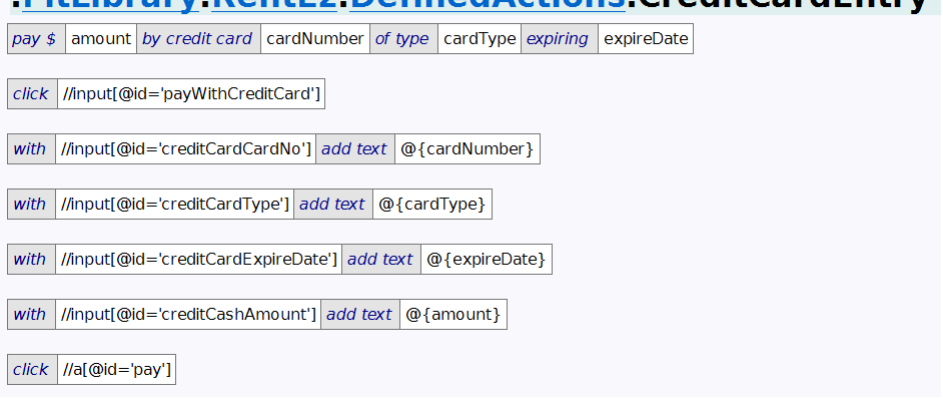
Figure 5. The resulting defined